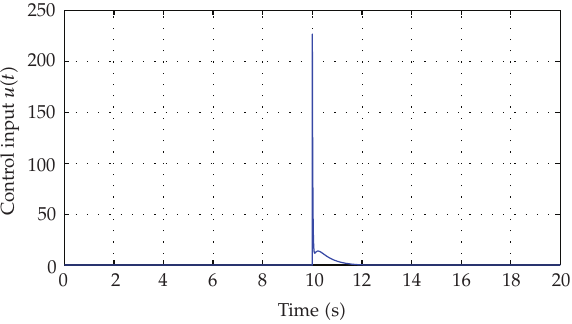
Figure 3: The time response of control input when α 0 (cid:8) 0 . 5 and p 1 (cid:8) 0 . 49 × sin (cid:2) t (cid:3) . The control is activated at time t (cid:8)